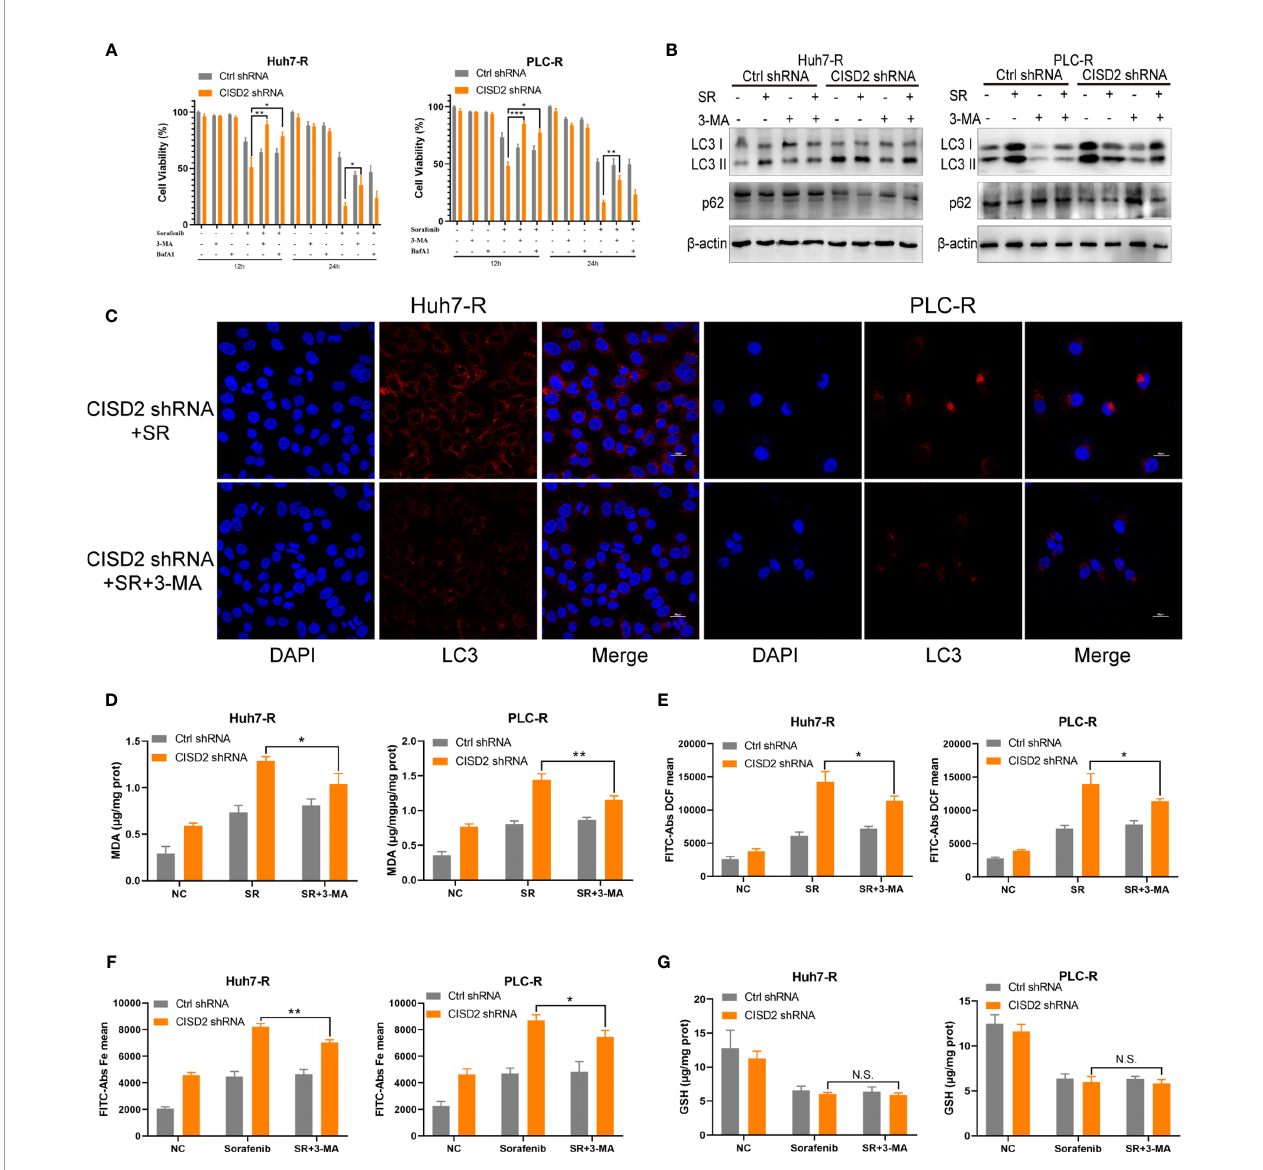
FIGURE 6 | Inhibiting autophagy alleviates ferroptosis in sorafenib-resistant cells with CISD2 knockdown. (A) CCK-8 was used to detect the cell viability under treatment with sorafenib (10 m mol), 3-MA (1 mmol), BafA1 (20 nmol), or transfected CISD2 shRNA (n = 3, * P < 0.05, ** P < 0.01, *** P < 0.001 versus 3-MA treatment or BafA1). (B) Western blot was used to detect the expression level of LC3, p62 under treatment with sorafenib (10 m mol), 3-MA (1 mmol), or transfected CISD2 shRNA in resistant cells. (C) Immuno fl uorescence was used to detect the expression level of LC3 under treatment with sorafenib (10 m mol), 3-MA (1 mmol), or transfected CISD2 shRNA. (D) MDA kit was used to detect the expression level of MDA under treatment with sorafenib (10 m mol), 3-MA (1 mmol), or transfected CISD2 shRNA (n = 3, * P < 0.05, ** P < 0.01 versus 3-MA treatment). (E) Flow cytometry was used to detect the expression level of ROS under treatment with sorafenib (10 m mol), 3-MA (1 mmol), or transfected CISD2 shRNA (n = 3, * P < 0.05 versus 3-MA treatment). (F) Flow cytometry was used to detect the expression level of iron ions under treatment with sorafenib (10 m mol), 3-MA (1 mmol), or transfected CISD2 shRNA (n = 3, * P < 0.05, ** P < 0.01 versus 3-MA treatment). (G) GSH kit was used to detect the expression level of GSH under treatment with sorafenib (10 m mol), 3-MA (1 mmol), or transfected CISD2 shRNA (n=3, N.S. means no signi fi